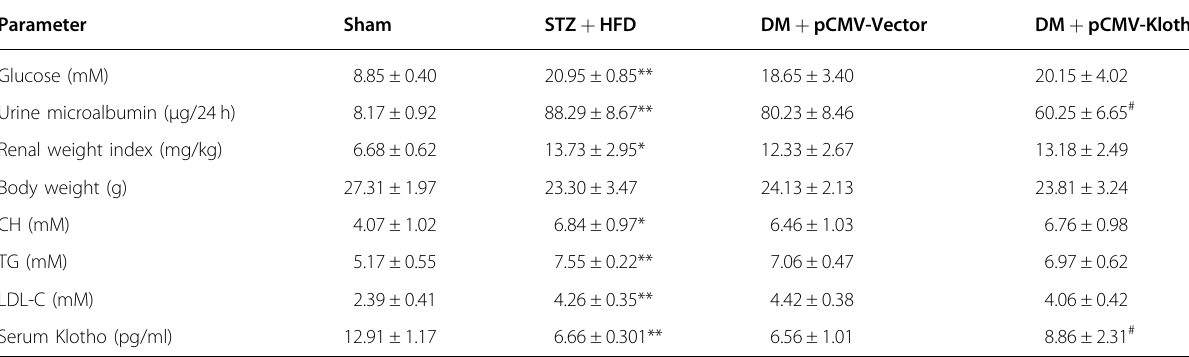
Table 3 Metabolic pro fi le analysis of mouse parameters.